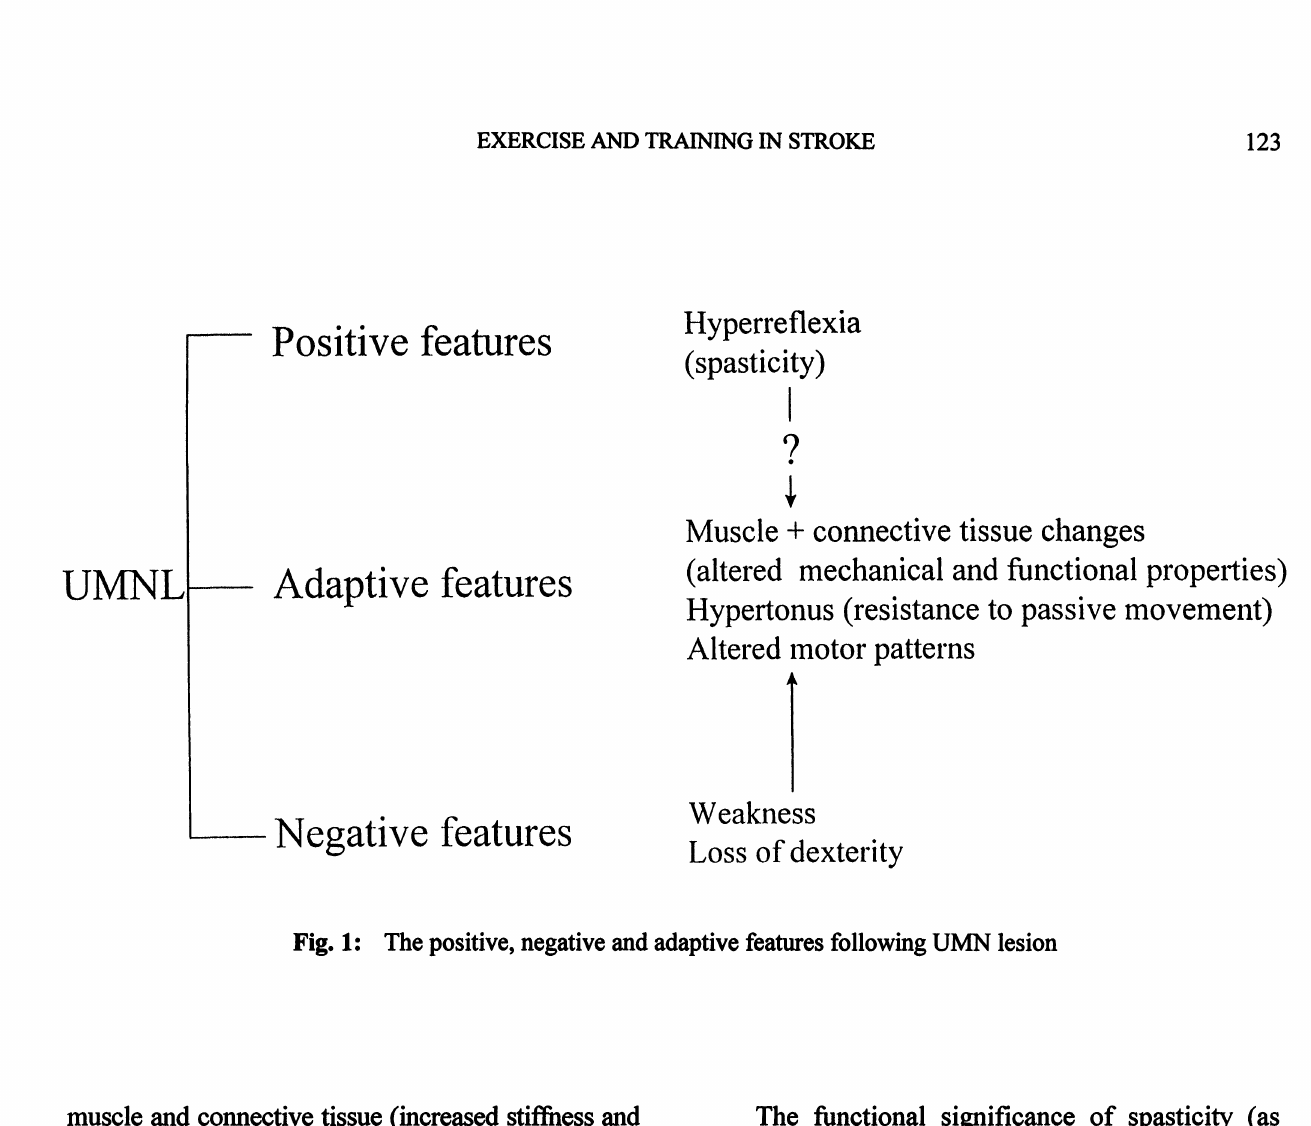
Fig. 1: The positive, negative and adaptive features following UMN lesion